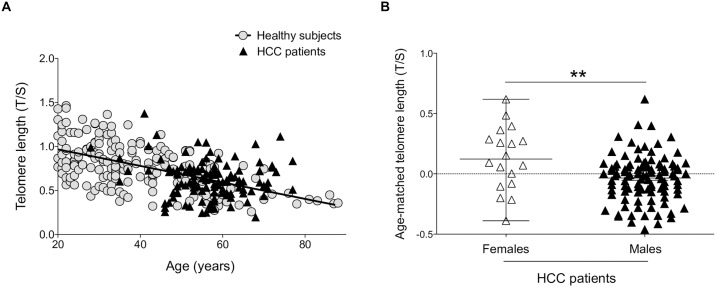
Distribution of age-matched telomere length in healthy subjects and HCC patients by qPCR.(A) Telomere length analysis revealed no statistical differences between HCC patients and healthy subjects analyzed by qPCR. Patients and controls were age-matched: Slope: −0.007882±0.0007139; y-intercept when x = 0: 1.080±0.02516). (B) Telomere length was longer in females than in males (**p = 0.01).